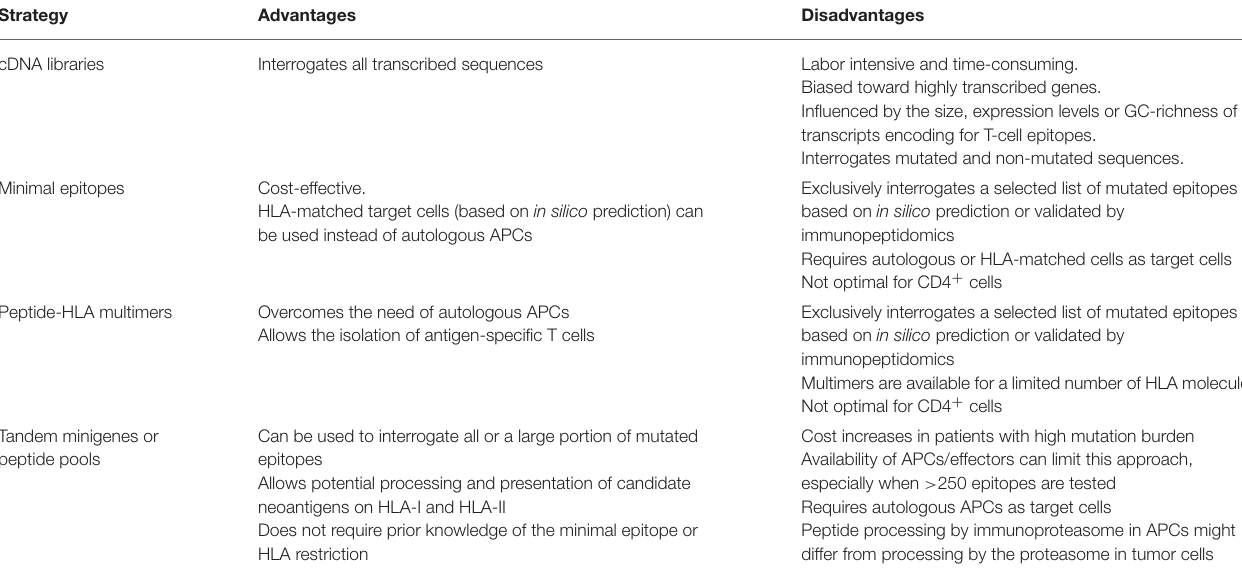
TABLE 3 | Immunological screening assays used to test for neoantigen